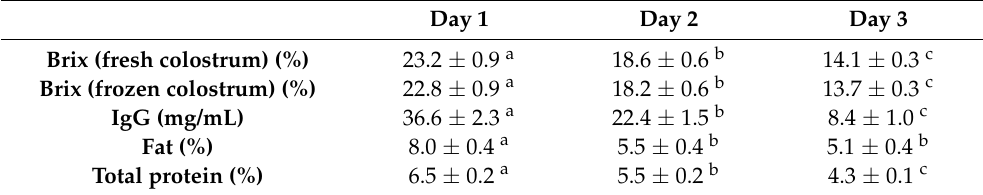
Table 1. Characteristics of goat colostrum collected on days 1, 2 and 3 after parturition.